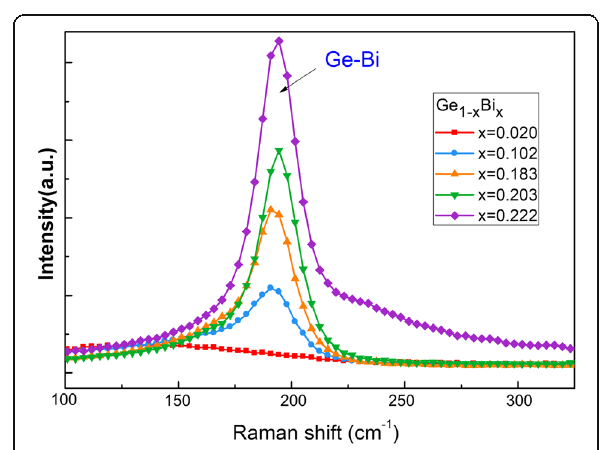
Fig. 4 Raman spectra of GeBi films with different Bi